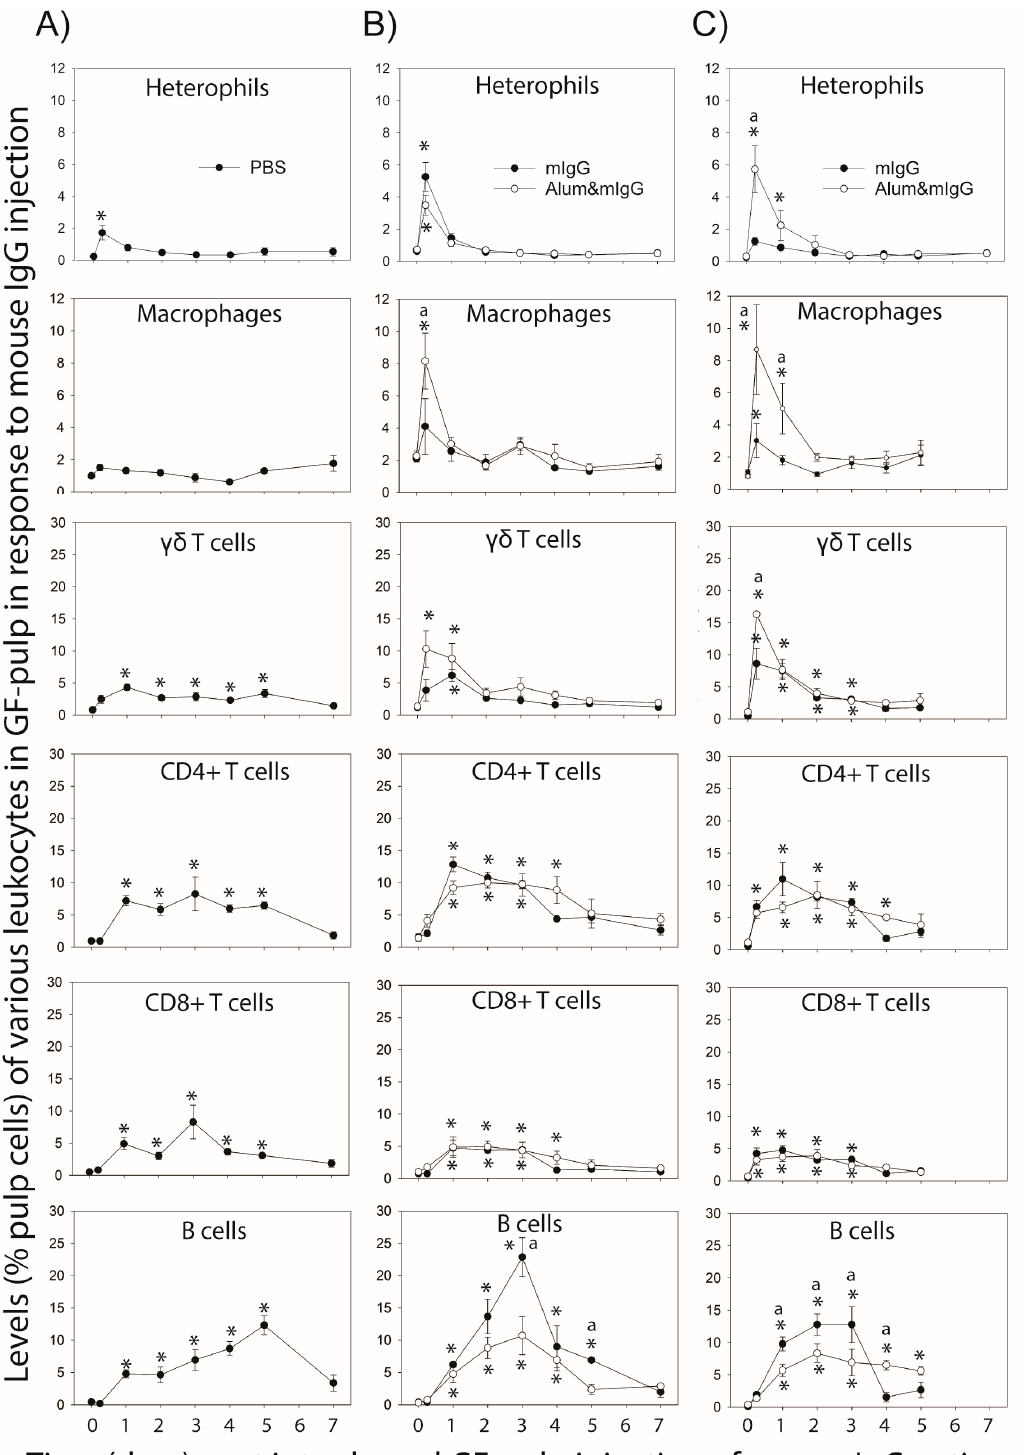
Figure 2. Leukocyte population profiles in response to intradermal (i.d.) injection of mouse IgG- antigen into the pulp of growing feathers (GF) in unsensitized (sham-(PBS) immunized) chickens ( A ), and in immunized chickens on Day 10 after the primary ( B ) or Day 5 after the secondary ( C ) intramuscular (i.m.) immunization with mouse IgG in PBS (mIgG) or mixed with alum adjuvant (Alum&mIgG). For immunization, male Light-brown Leghorn chickens were injected i.m. with 26 µ g of mIgG in endotoxin-free (EF) PBS or mIgG mixed with 15% alum adjuvant in EF-PBS; four